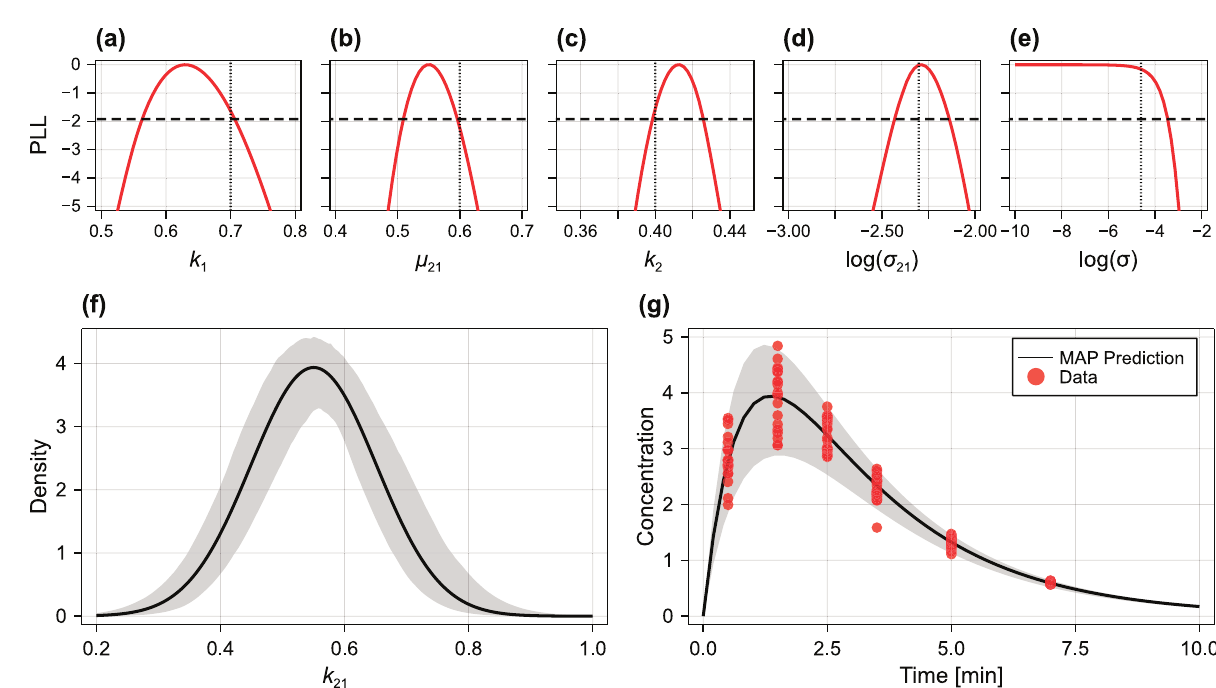
Fig 6. Identifiability analysis for two-pool model with random parameters. (A–E) Profile likelihoods for each hyperparameter. Also shown are the true values (vertical dotted) and the threshold for a 95% confidence interval (horizontal dashed). (F) Inferred distribution of k 21 showing the distribution at the MAP (black) and a 95% credible interval for the density function. (G) Synthetic data (red discs) and model prediction based on the MLE showing the mean (black) and 95% prediction interval (grey).